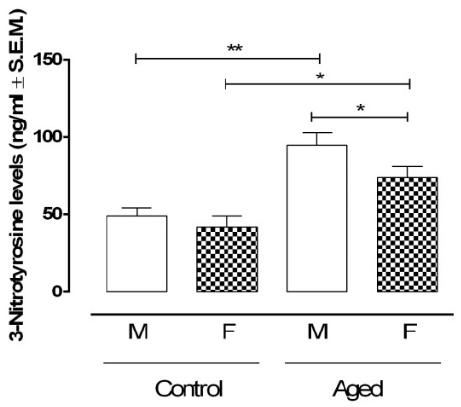
Figure 7. 3-Nitrotyrosine retinal levels. ELISA determination of 3-Nitrotyrosine as a marker of peroxynitrite formation in aged and younger (control) retina. Data are expressed as mean ± S.E.M. of N = 10 retinas for each group. M: males; F: females; ** p < 0.01; * p < 0.05.